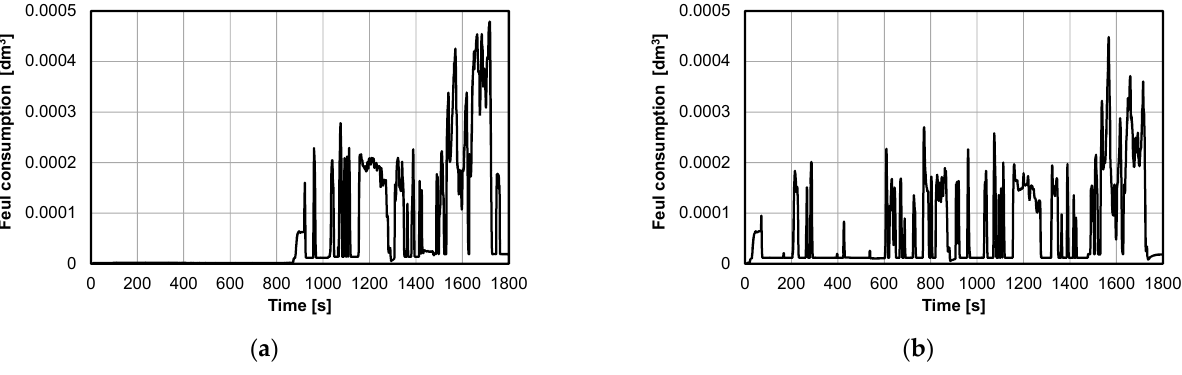
0.0002 dm 3 , and the fuel consumption upper level decreased in a complex, oscillating-like manner with the increase in absolute velocity. In both cases, it was not only due to driving with a competitive choice between a combustion engine and electric motor, but also to other factors, as there were three or four possible distinctive levels of fuel consumption for the same absolute velocity values. Figure 20. The THC concentration versus time for: ( a ) plug-in; ( b ) HEV. Figure 20. The THC concentration versus time for: ( a ) plug-in; ( b ) HEV.